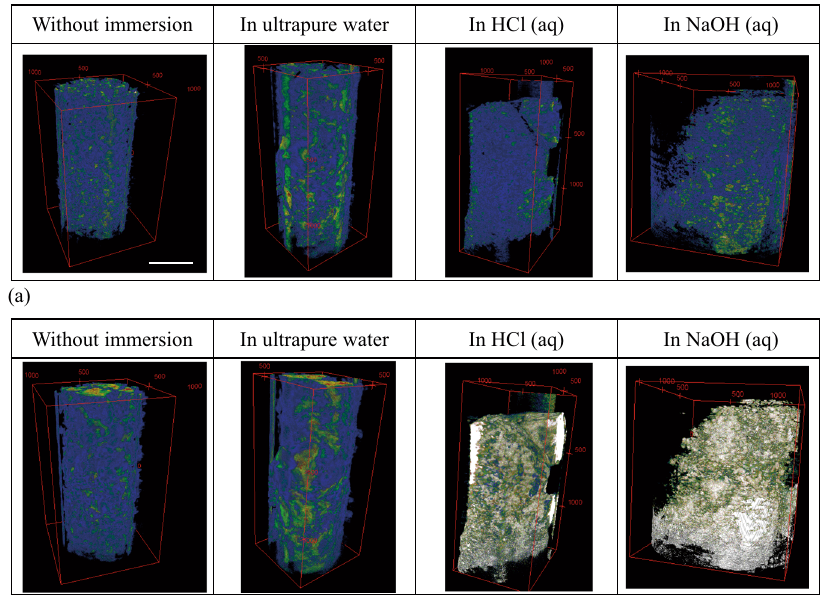
Fig. 6 The three-dimensional image of the zircon particles before and after immersion in each solution measured using synchrotron X-ray microtomography with the energy around Zr K-edge. The scale bar is 100 μ m. a Energy weaker than Zr-K edge (17.9 keV). b Energy stronger than Zr-K edge (18.1 keV).